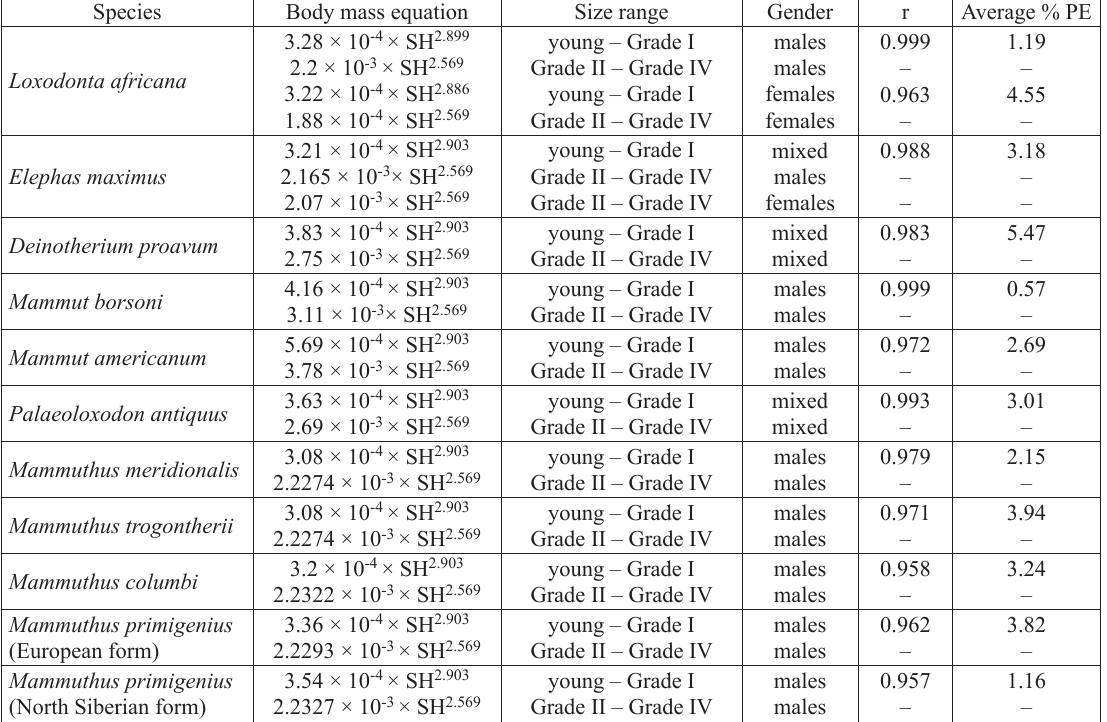
Table 7. Developed equations for body mass estimation of different proboscidean taxa from young to average-sized individuals and from large (> 5% taller than average) to record-sized individuals, based on the relationship between shoulder height (SH) and body mass calculated in this study. Correlation coefficients (r) and prediction errors (PE) are not possible to calculate for specimens within Grade II to IV, because these equa- tions are based on the proposed allometric growth curve (see Fig. 9) for animals above the average, and can not be tested because the scarcity of the individuals of this size